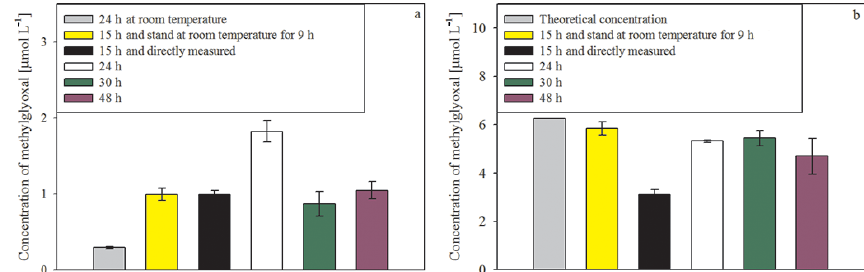
Figure 1. Influence of the heating time on the detected methylglyoxal concentrations in filter samples (a) and the methylglyoxal standard solution (b)